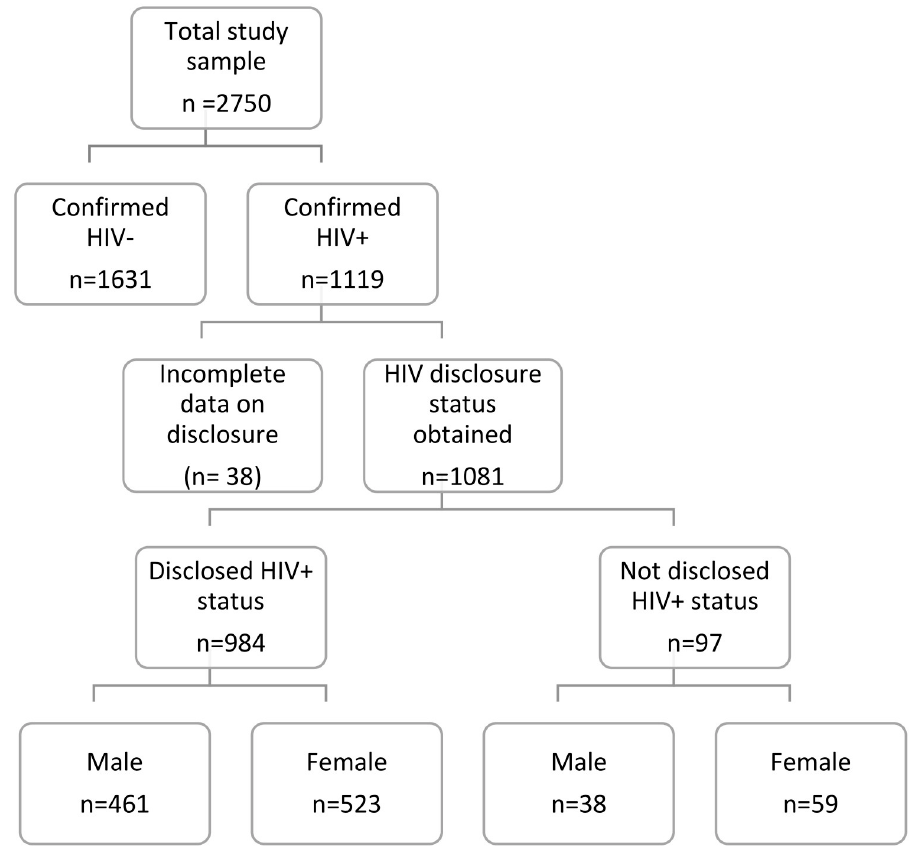
Fig 1. Analysis flowchart: Study participants’ HIV status, and whether disclosed status, at baseline. A diagram of study participants by HIV status and HIV status disclosure. In a sample of 2750 study paricipants (selected for balance by region, sex, mobility, and HIV status), 1119 were confirmed to be living with HIV, with 91.0% (n = 984) having ever disclosed their HIV status to others (outside a clinic setting) and 9.0% (n = 97) with HIV status not disclosed, at study